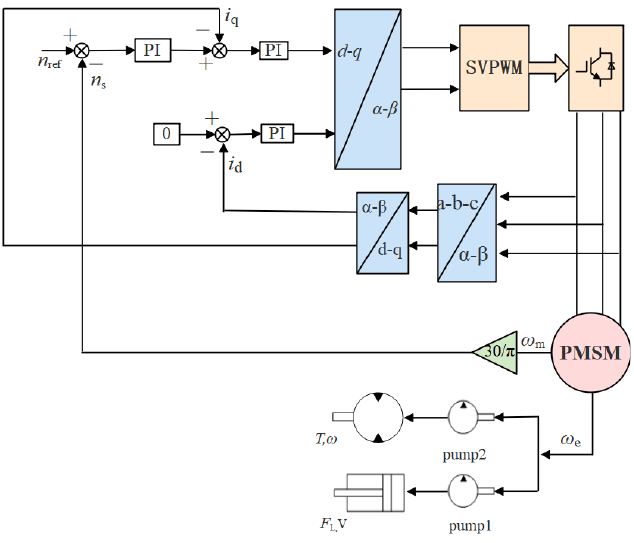
Figure 3. Functional block diagram of pump controlling the hydraulic system based on the CSPI.